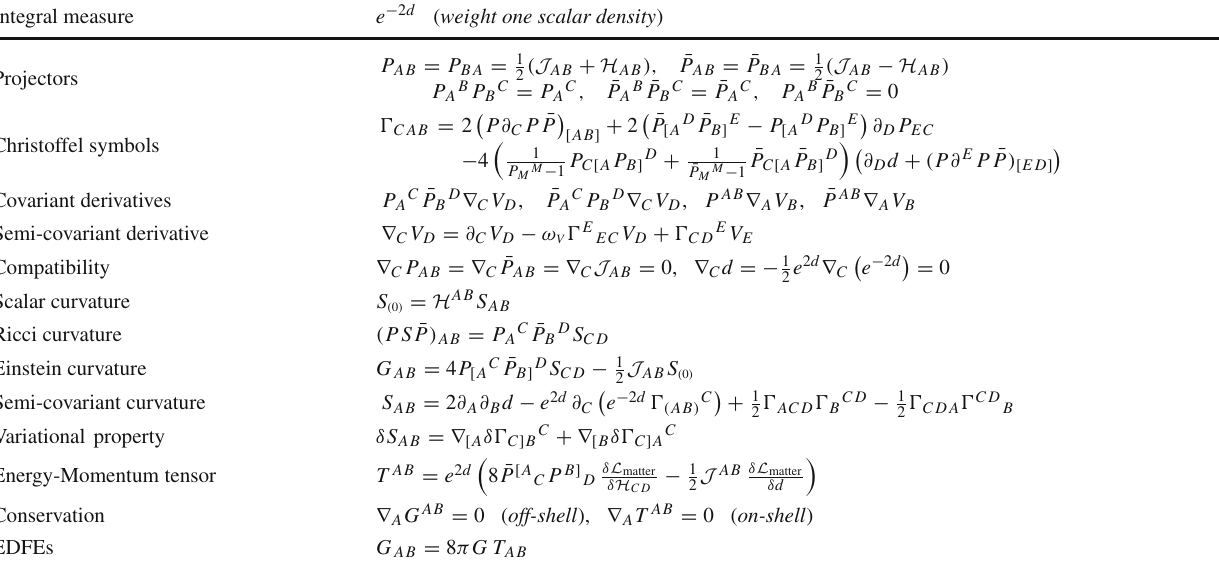
Table 1 Geometric notation for DFT. For latest exposition see e.g. section 2 of [65] Integral measure e − 2 d ( weight one scalar density